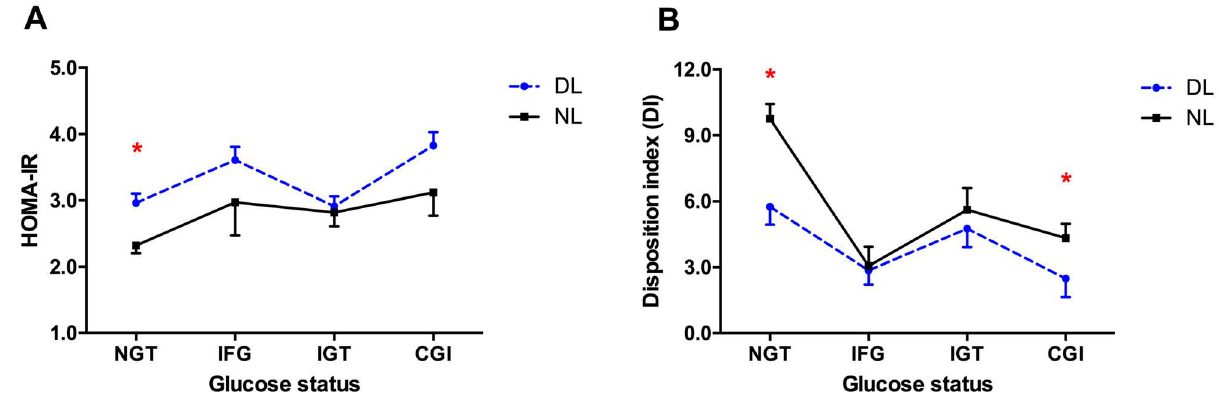
Fig 1. Insulin resistance and β cell function evaluation in non-diabetic subjects with or without dyslipidemia. HOMA-IR: homeostasis model assessment for insulinresistance, DI: dispositionindex, NL: normallipid, DL: dyslipidemia, NGT: normal glucose tolerance, IFG: impairedfasting glucose,IGT: impaired glucosetolerance, CGI: combinedglucoseintolerance. * P < 0.05 versus normal lipid (NL) group. Data were expressedas mean ± SD, which were calculatedafter adjustingfor age, sex, SBP, DBP, BMI and WHR.